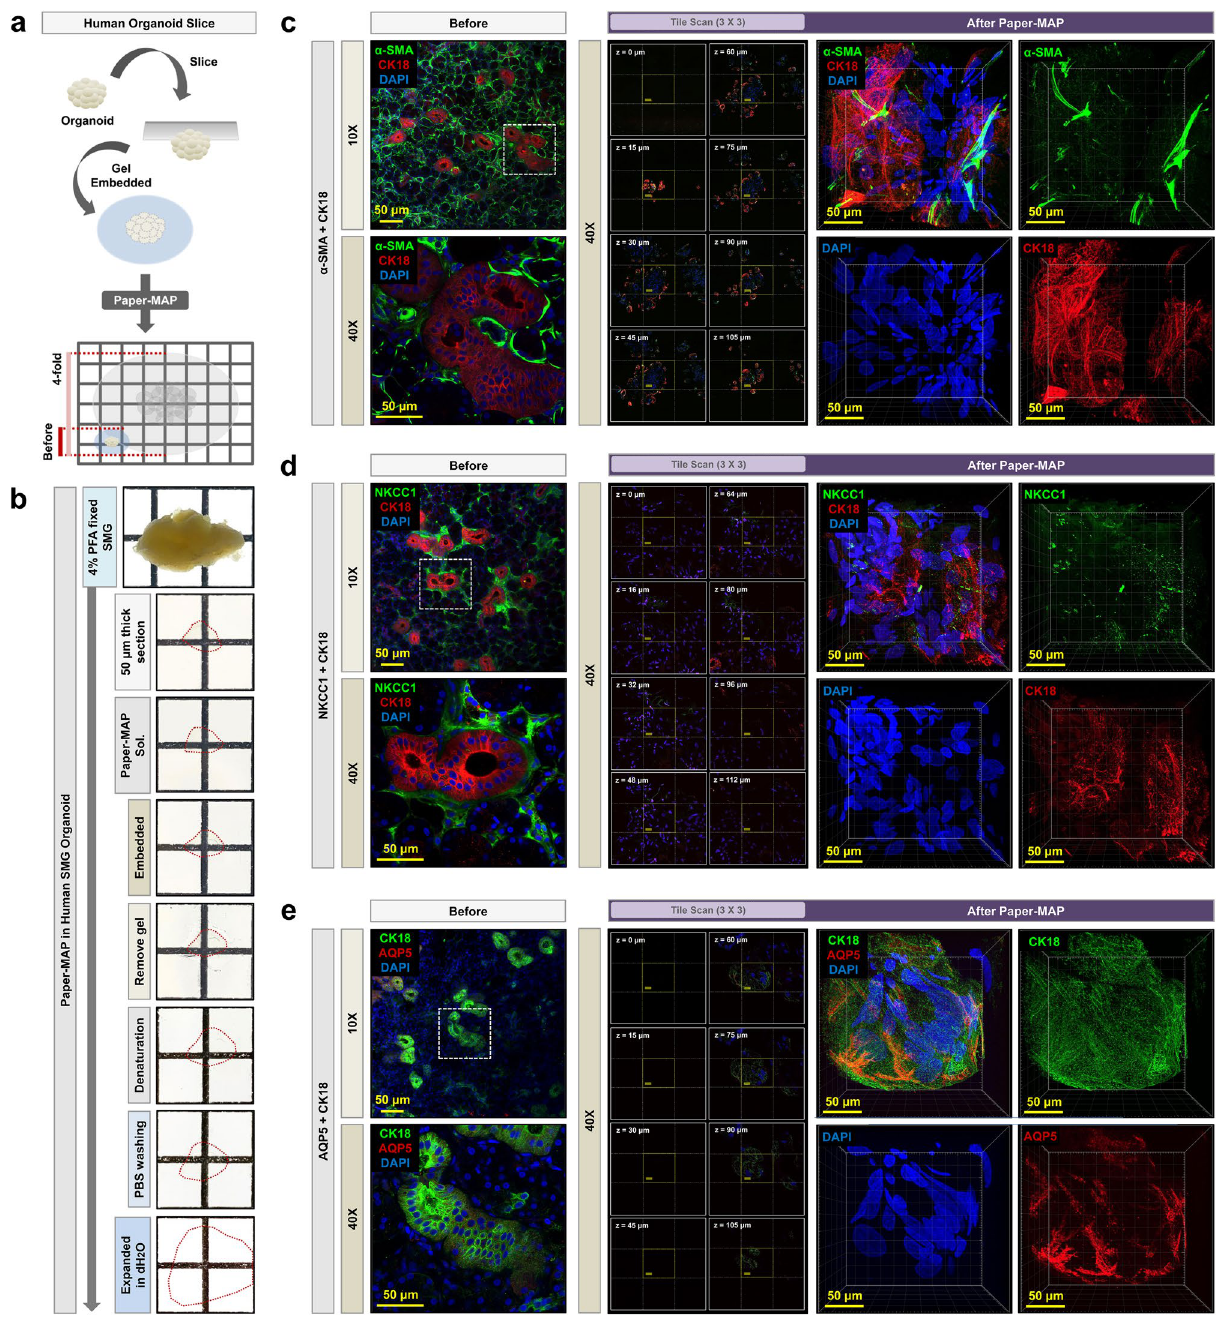
gland (SMG) organoid sections. ( b ) Optical transparency of human SMG organoid achieved via Paper-MAP. ( c-e ) Paper-MAP processing of human SMG organoids and subsequent immunostaining (range: 100-μm) for alpha-SMA (green), CK18 (red or green), NKCC1 (green), AQP5 (red) and DAPI (blue). Images of before (left, fixed in 4% PFA) and after Paper-MAP (right) was taken with the same 10 × and 40 × objective lens and z-stacked (range: 100-μm) for comparison. Scale bars: yellow = 50-μm. Illustration of mechanism is visualized by PowerPoint